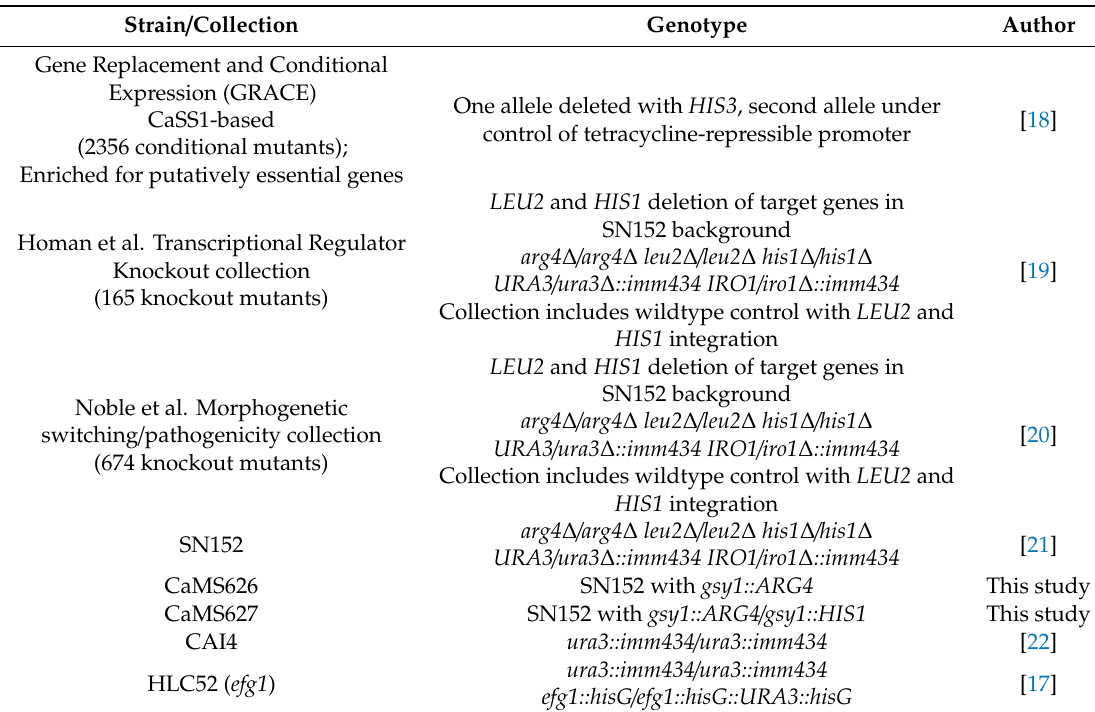
Table 1. C. albicans strains used in this